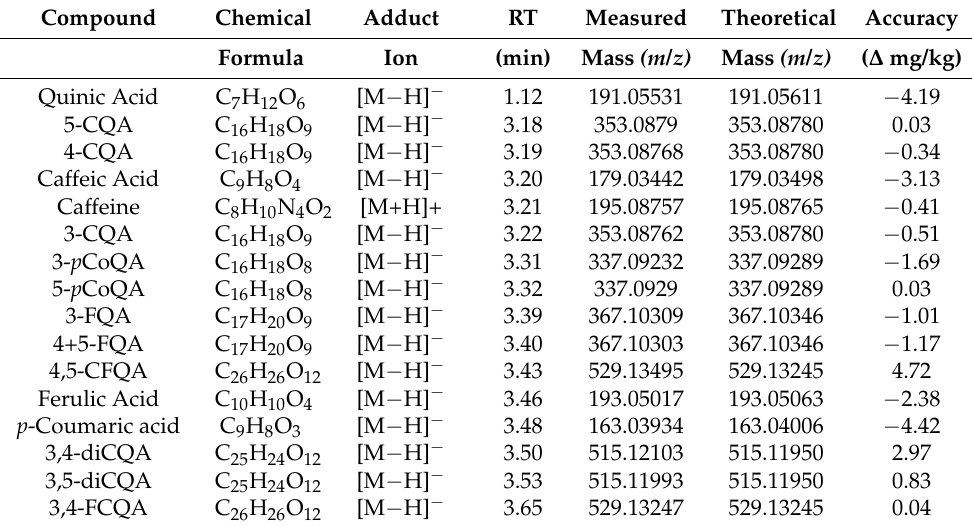
Table 1. UHPLC-MS parameters of the assayed analytes ( n =